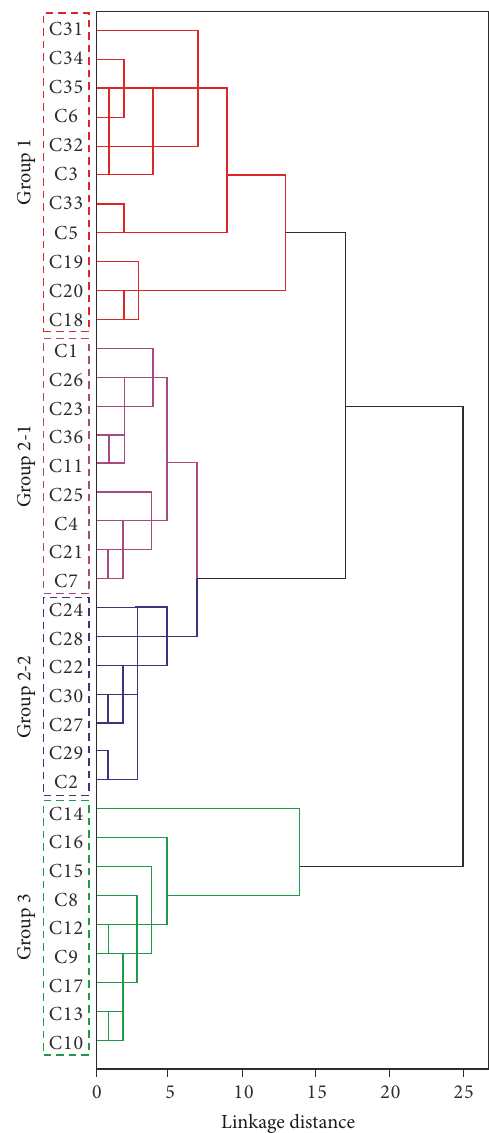
Figure 4: Dendrogram showing the results of the cluster analysis performedonthegeothermalspringsamplesfromtheresearcharea.